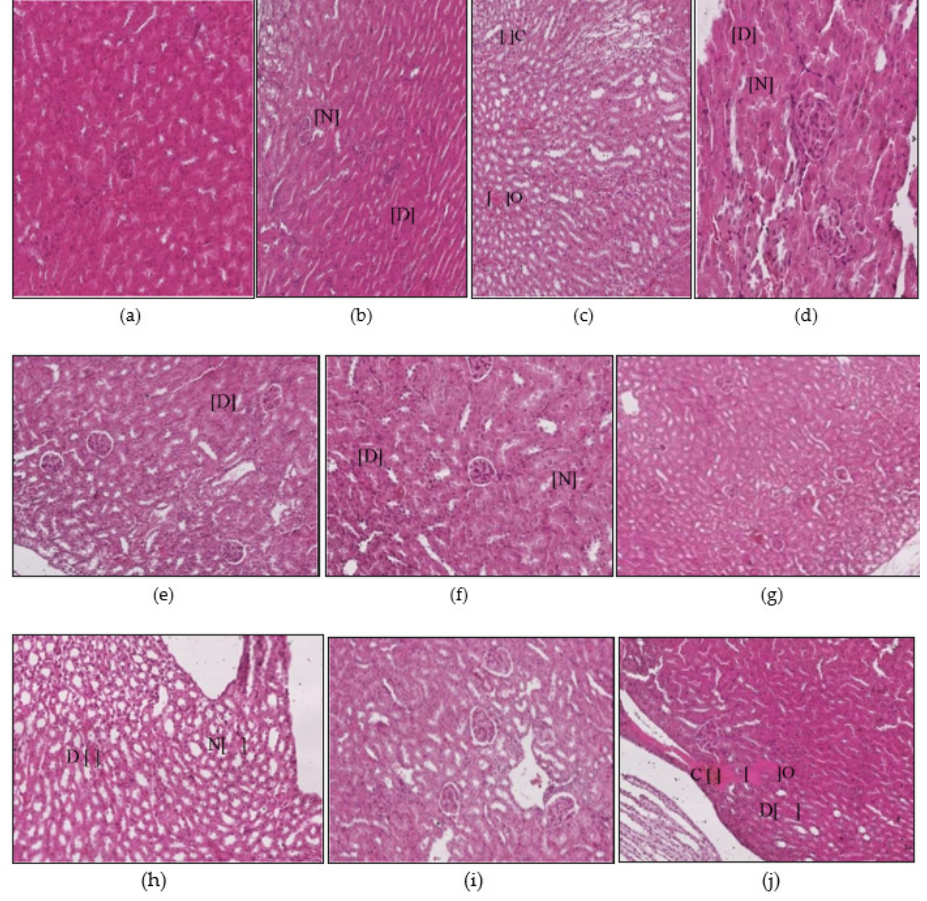
Figure 6. Histopathological photomicrographs (H&E, 400×) of kidney tissues showing microscopically observed control ( a ), and the changes after exposure to mosquito repellant ( b – d , Mat-based vapor, Liquid formulation vapor, and Burning-coil-based smoke groups, respectively), and supplementations of pyrethroid-exposed animals with ascorbic acid ( e – g , Mat-based vapor and AA, Liquid formulation vapor and AA, and Burning-coil-based smoke and AA groups, respectively), or E307 ( h – j , Mat-based vapor and E307, Liquid formulation vapor and E307, and Burning-coil-based smoke and E307 groups, respectively). Areas in the figures marked with abbreviations in parentheses represent the cytoplasmic degeneration of renal tubular cells (D), renal tubules occlusion by hyaline (O), necrotic tubules (N), and congestion and dilation of blood vessels (C).